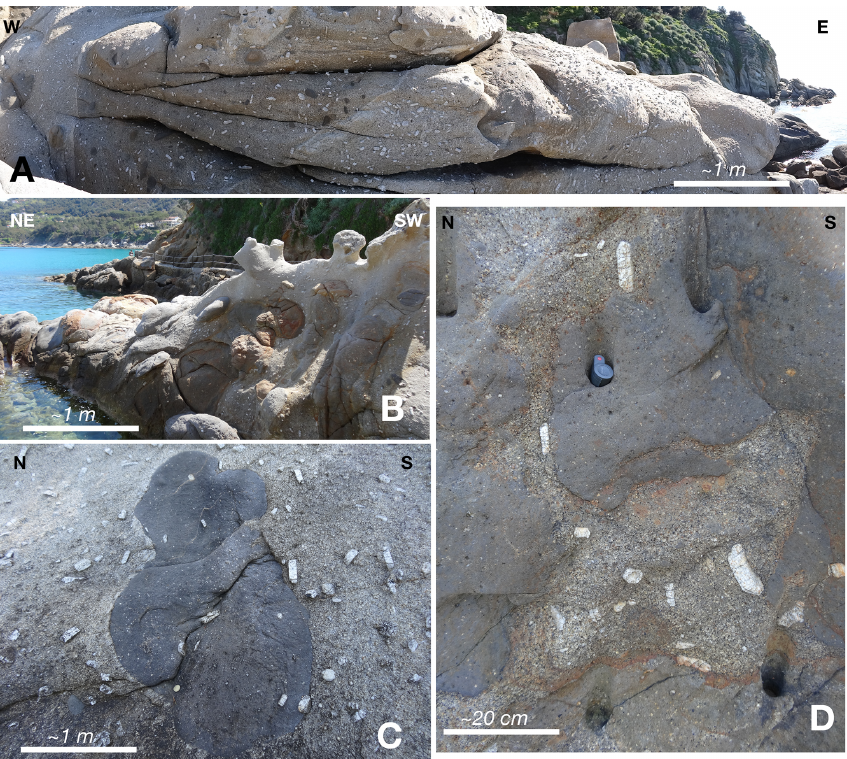
Figure 11. Photographs of large mafic enclaves and melange zones in the westernmost part of the Sant’Andrea facies showing the disorien- tation of K-feldspar megacrysts and melange facies